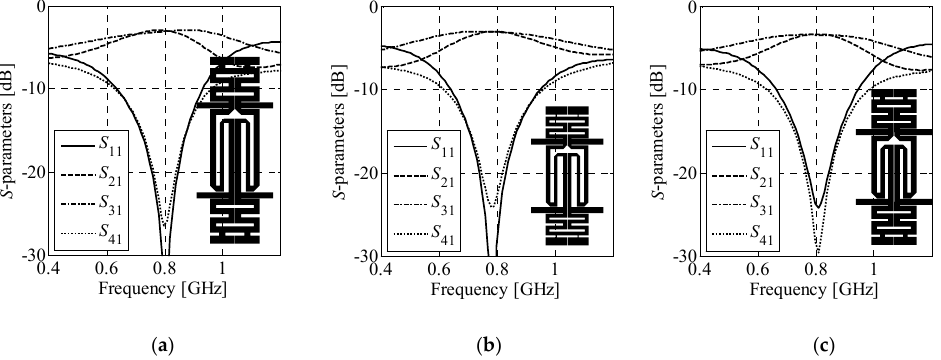
Figure 14. Frequency characteristics and geometries (in-scale) of the B A (2,4) coupler re-designed to work on: ( a ) Arlon AD250C, ( b ) Arlon AD300C, and ( c ) FR-4 substrates. Table 4. Dimensions of the B A (2,4) coupler re-designed for different substrates.